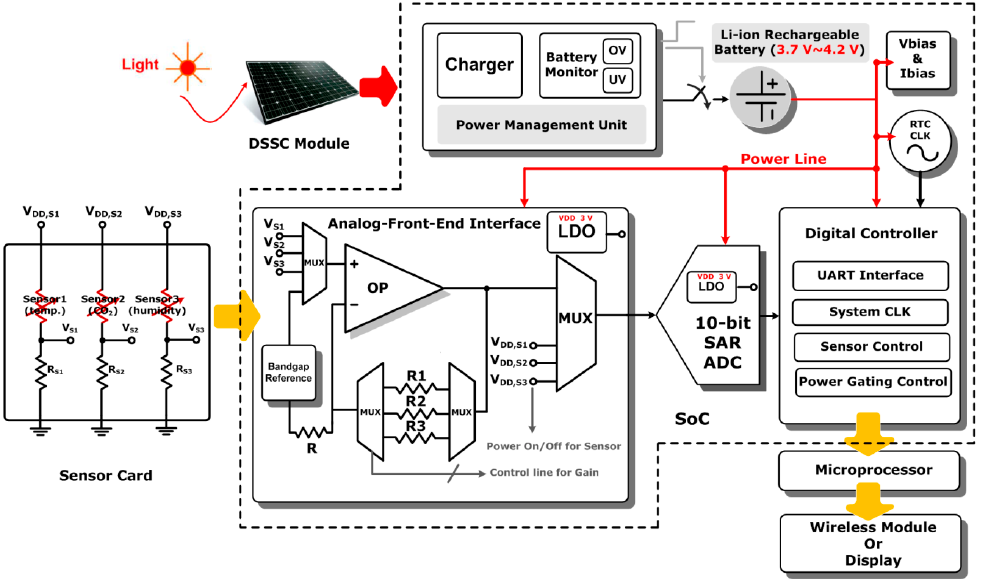
Figure 2. The block diagram of the designed system-on-chip (SoC) sensing platform with a replaceable sensor card.